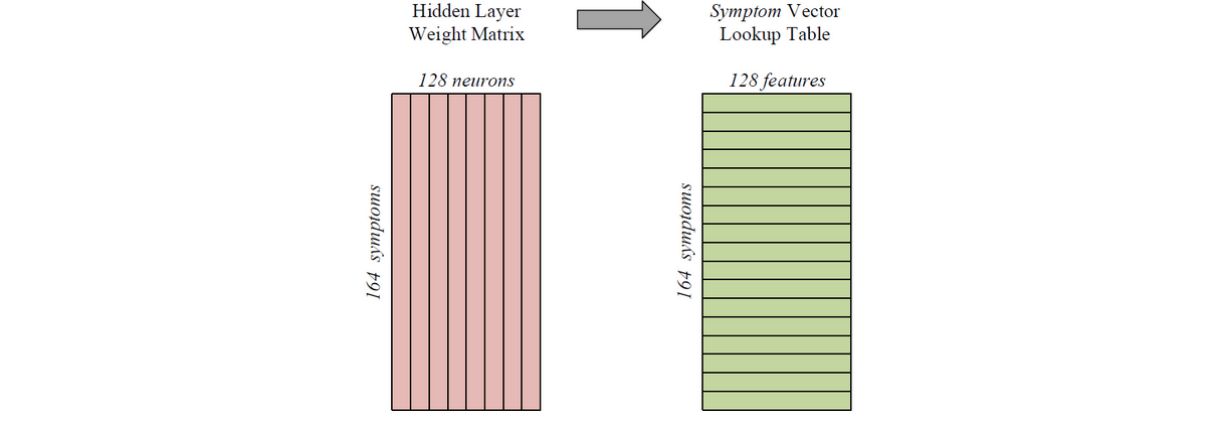
Figure 5. Representation of symptom